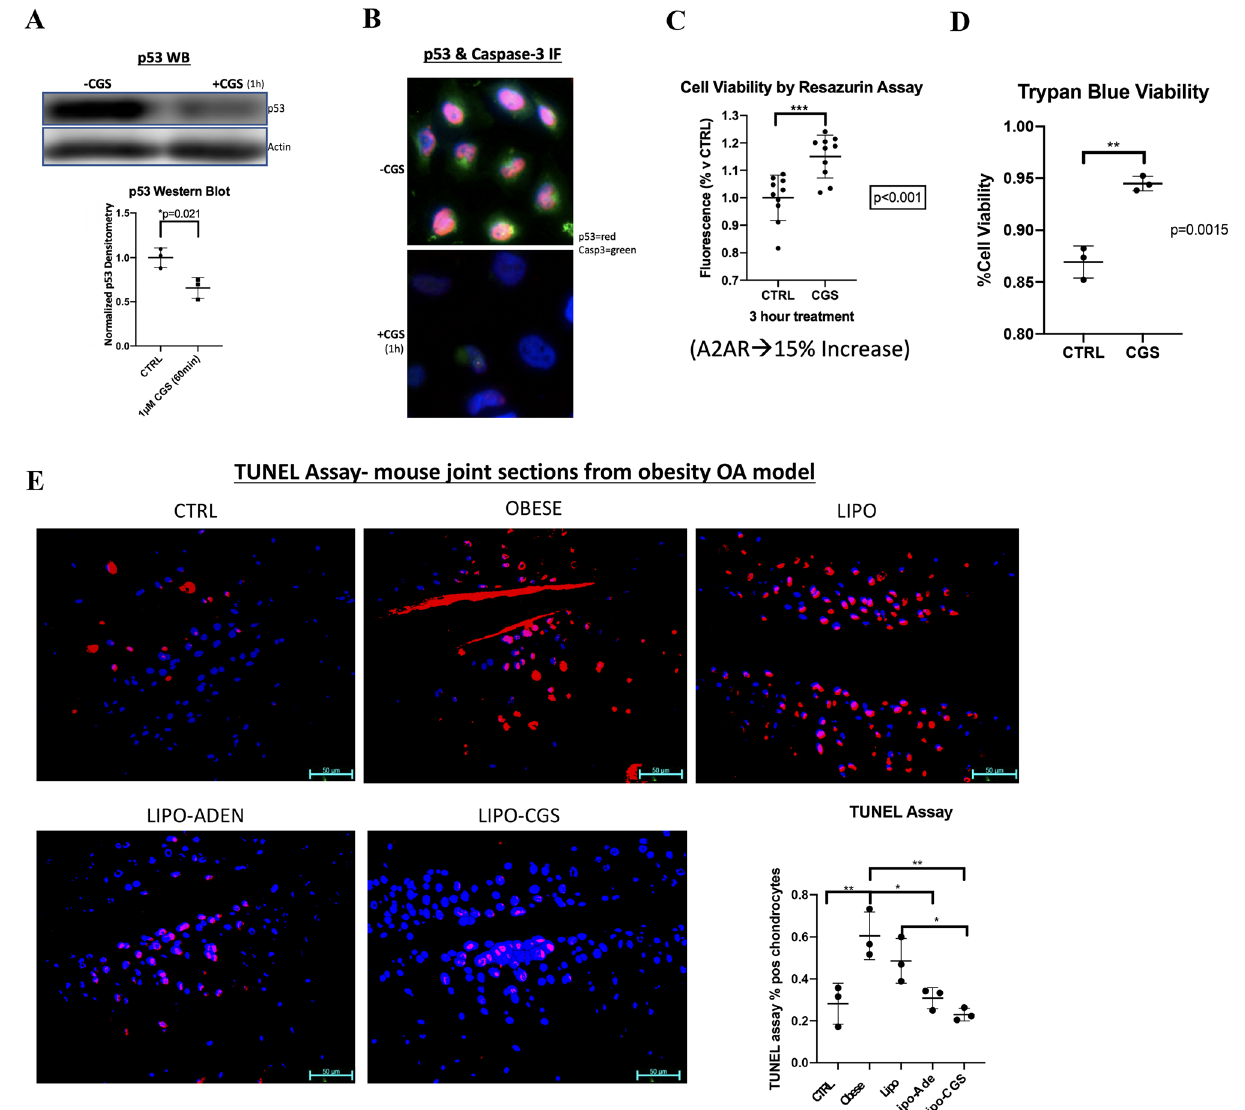
Figure 4. The increased autophagy observed with A2AR stimulation is also associated with decrease in apoptosis markers in TC28 ⍺ 2 human chondrocytes. ( A ) Western blot of total protein extract in TC28 ⍺ 2 human chondrocytes treated with or without 1 µM CGS for 1 h measuring p53 and loading control beta-actin. Calculation of p53/Actin densitometry in separate experiments from TC28a cells treated with or without CGS21680 vs. CTRL (0.69 ± 0.072 vs. 1.0 ± 0.067, n = 3, p < 0.05)). ( B ) CGS21680 treatment of TC28a2 cells by IF shows decrease in p53 (red) after 1 h 1 µM CGS21680 treatment (+ CGS) compared to control